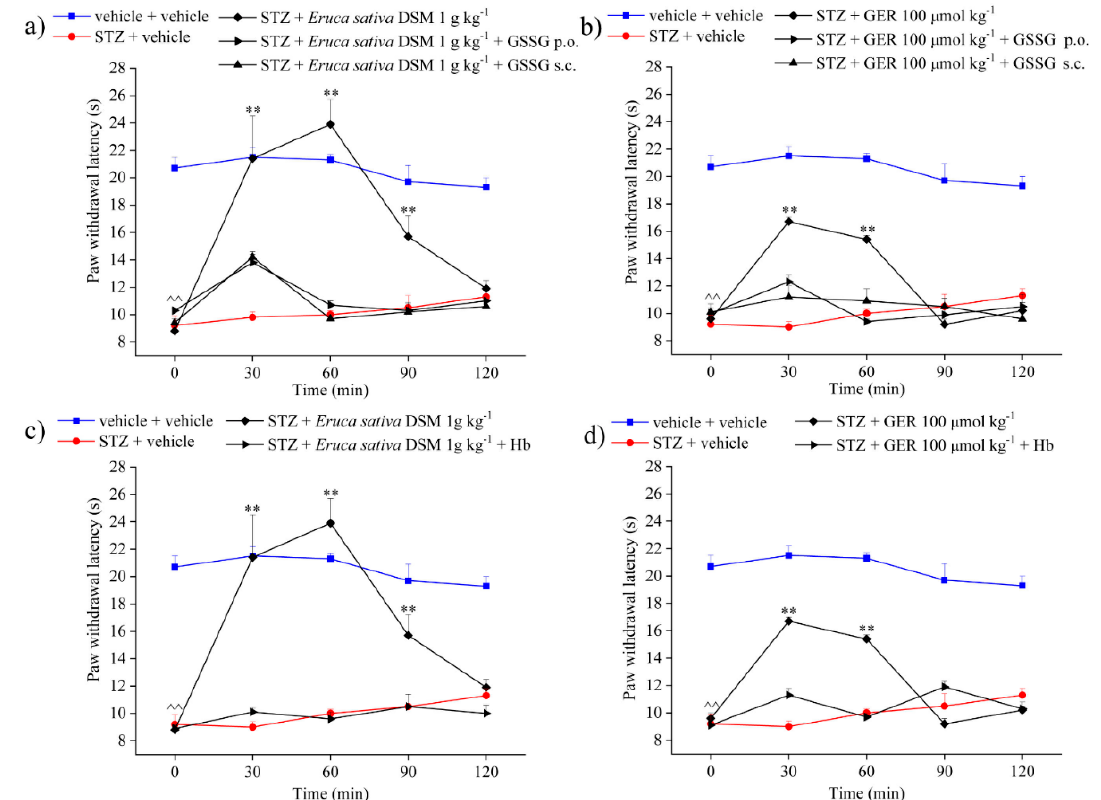
Figure 4. Role of H 2 S in the pain-relieving effect of Eruca sativa defatted seed meal (DSM) and glucoerucin (GER). The response to a mechanical stimulus was evaluated by measuring the latency(s) to pain-related behavior (paw withdrawal). Oxidized glutathione (GSSG) (20 mg kg − 1 ) was orally and subcutaneously administered in concomitance with both ( a ) Myr-bioactivated Eruca sativa DSM (1 g kg − 1 ) and ( b ) GER (100 µmol kg − 1 ); tests were performed 30, 60, 90, and 120 min after injection. ( c )